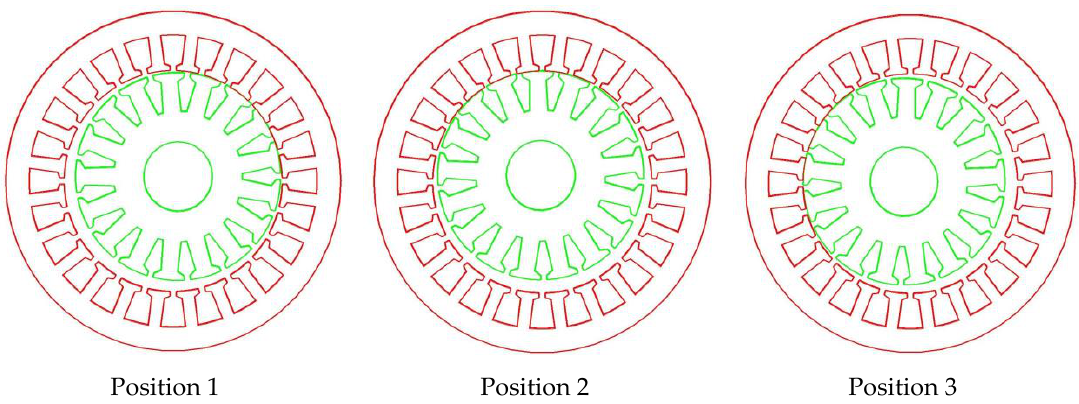
Figure 4. Sequence of shots showing a continuous rotor movement.